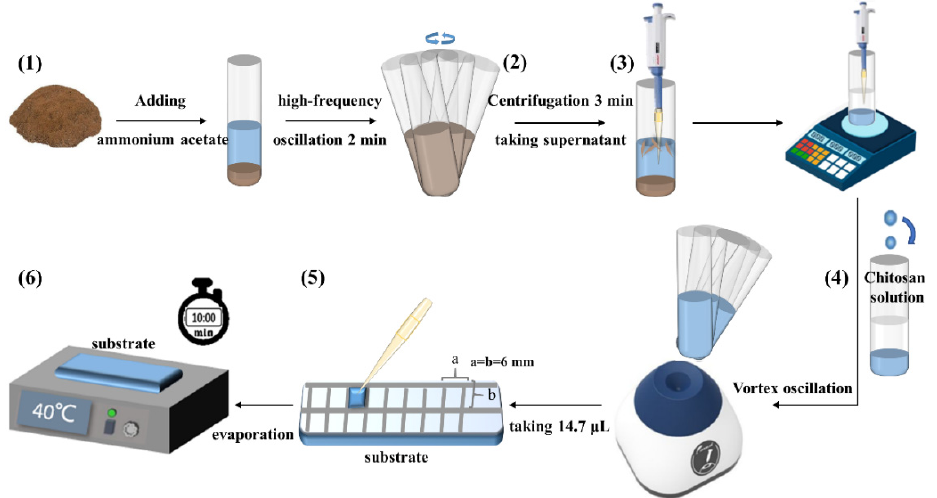
Figure 2. The preparation steps of